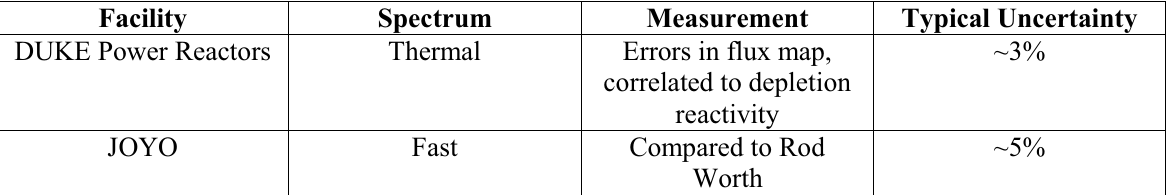
Table V.: Burnup reactivity experimental benchmarks in the IRPhEP Handbook Facility